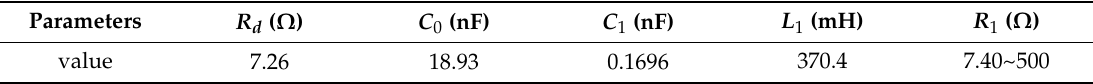
Table 1. Parameters of the BVD model for the